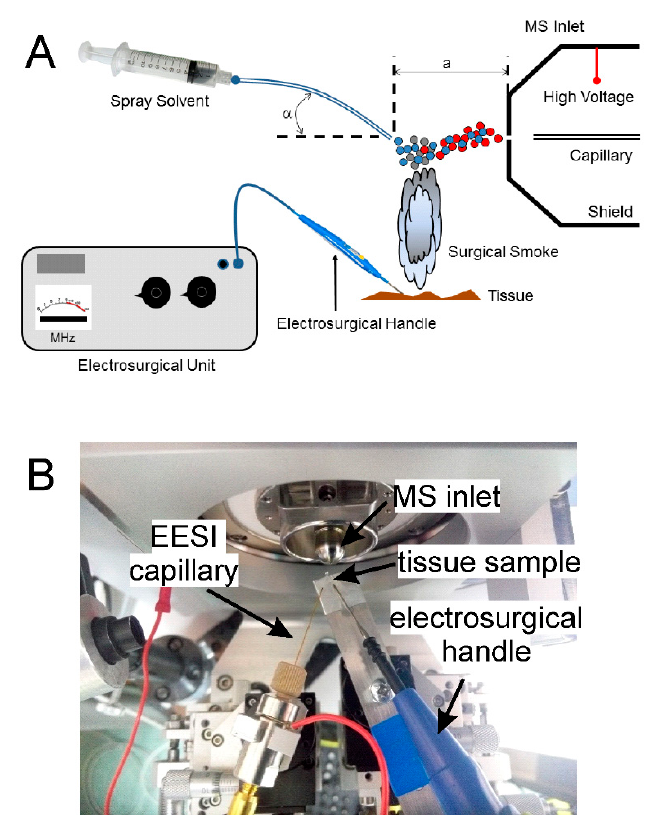
Figure 1. The schematic setup ( A ) and a photo of the ionization source ( B ).